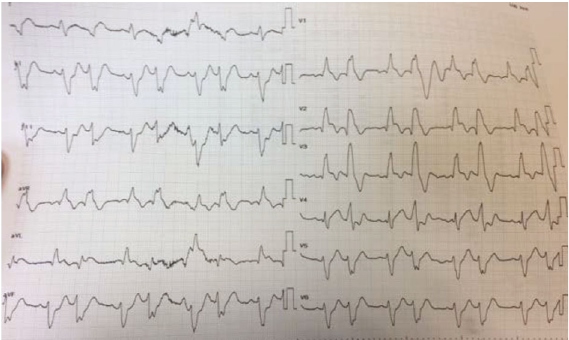
Figure 1: Electrocardiogram at presentation: sinus rhythm, STEMI in anterior chest leads, left axis deviation, PVCs in bigeminy pattern.